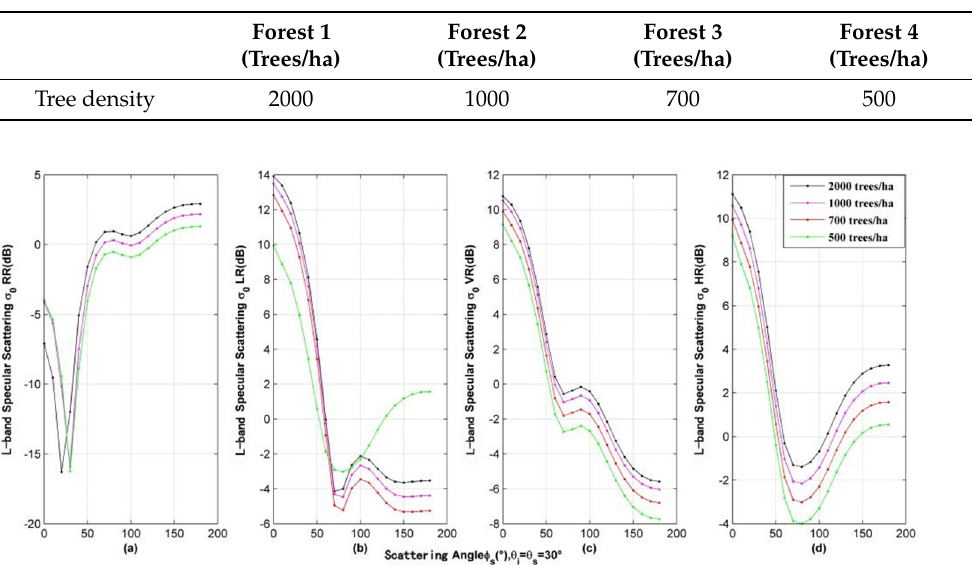
Figure 6. Specular scattering properties of various polarizations at different tree densities. ( a ) RR polarization; ( b ) LR polarization; ( c ) VR polarization; ( d ) HR polarization.